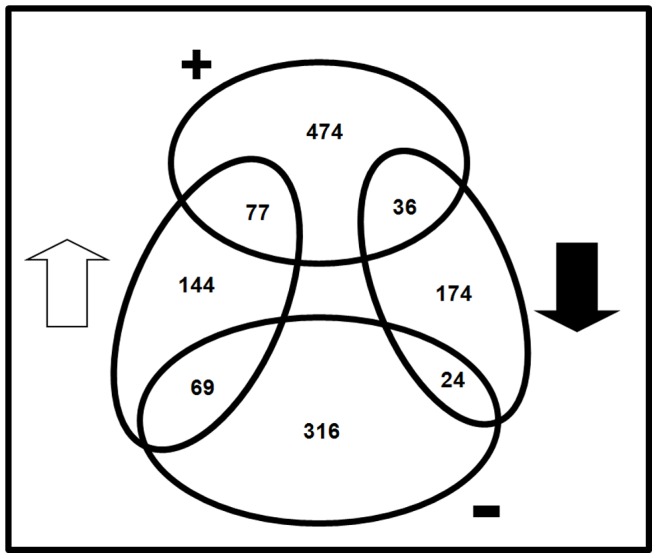
Venn diagram summarizing the number of differentially expressed genes of Azoarcus sp. BH72 from two different transcriptome studies (N2 response and NifA regulon) and their overlap.The numbers within the ovals represent genes modulated under the microarray experiments. Non-filled arrow and solid arrow represent up-regulation and down-regulation of genes under N2 fixation, respectively. The+or – symbols represent genes positively or negatively regulated by NifA, directly or indirectly, under N2-fixing condition. The circles and region of overlap are not drawn to scale.